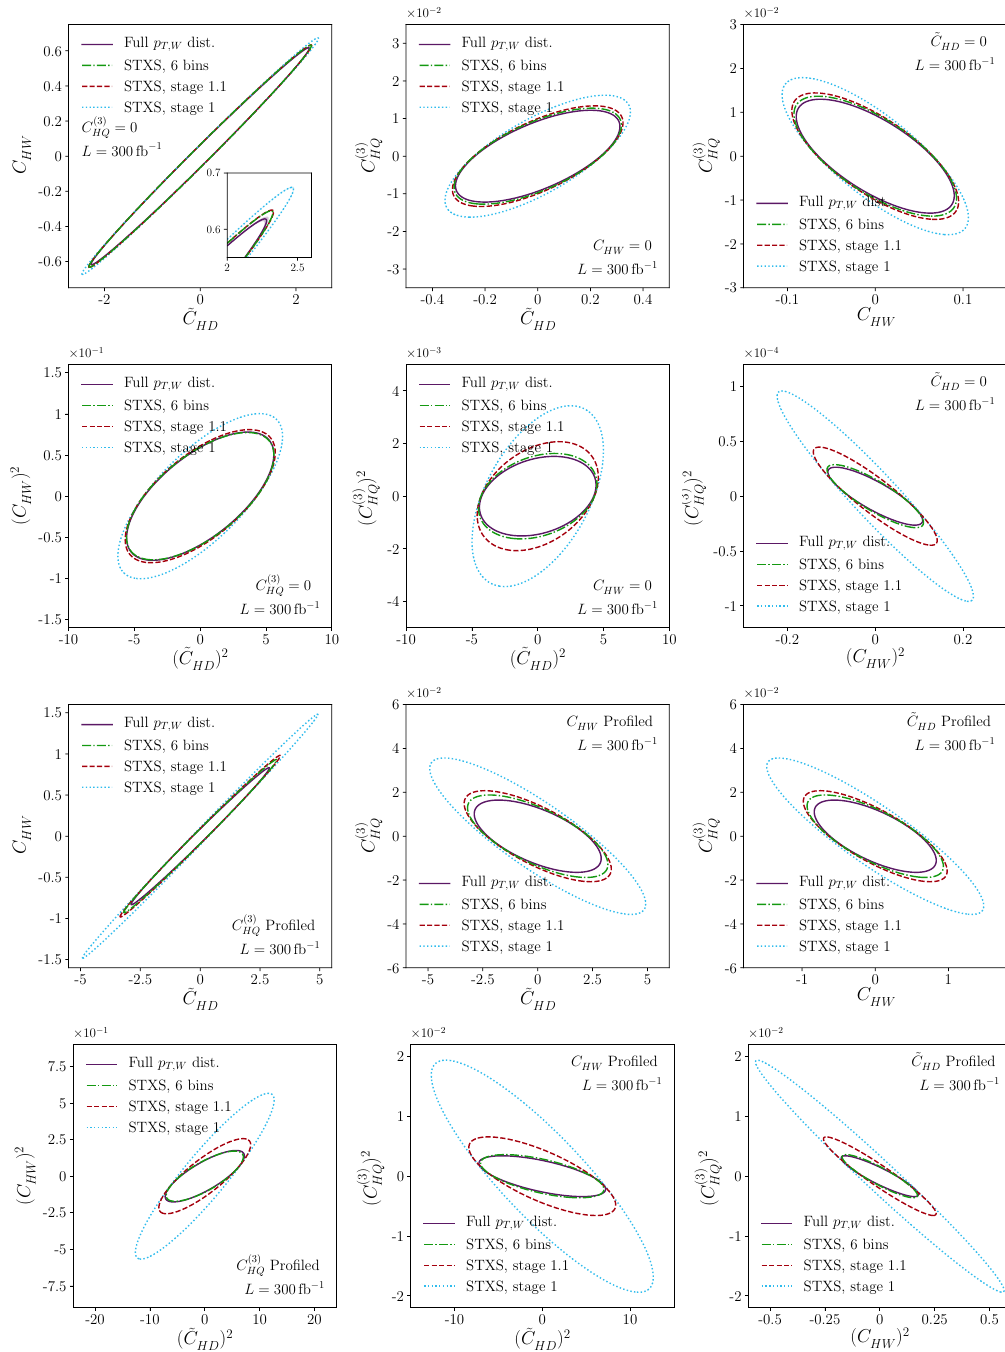
Figure 5 . 95% CL constraints based on p T;W in the Fisher information approximation. We show linearized and squared-only results setting the third operator to zero (top six panels) and pro(cid:12)ling over the third operator (bottom six panels). The blue dotted line shows the STXS stage 1 (3 bins), red dashed stage 1.1 (5 bins), and green dot-dashed and purple solid show the results when adding a 6th bin or including the full p T;W